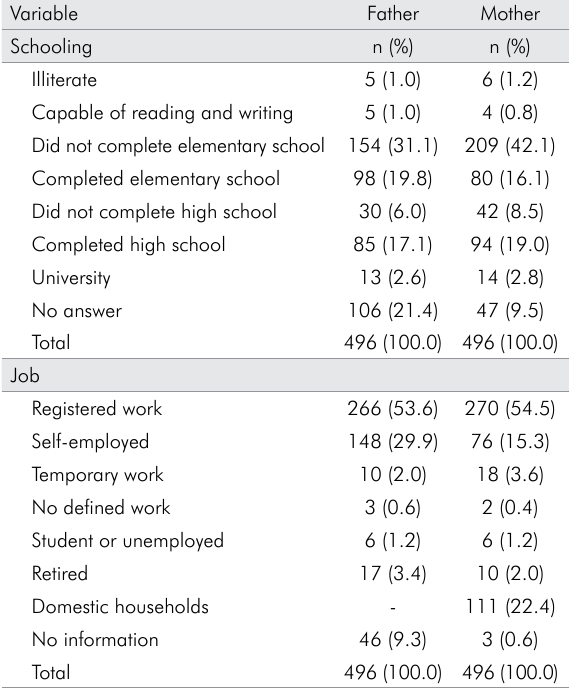
Table 5. Absolute and perceptual distribution of fathers and mo- thers, according to their schooling and job. Birigui, SP, Brazil, 2014.